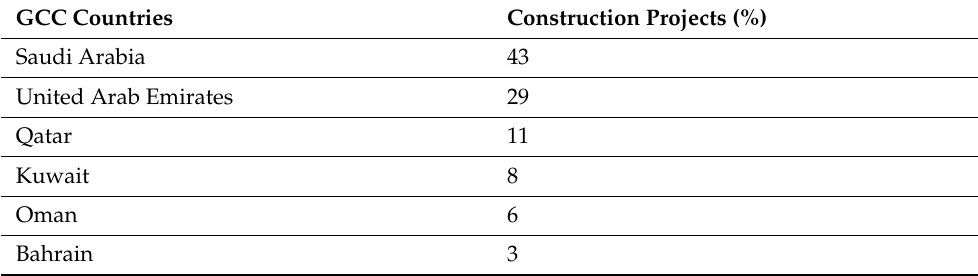
Table 1. Percentage of construction projects [12]. GCC